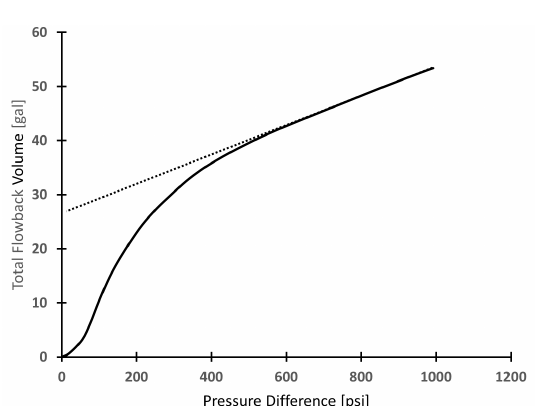
Figure 4. Flowback volume vs. Pressure Difference [30].